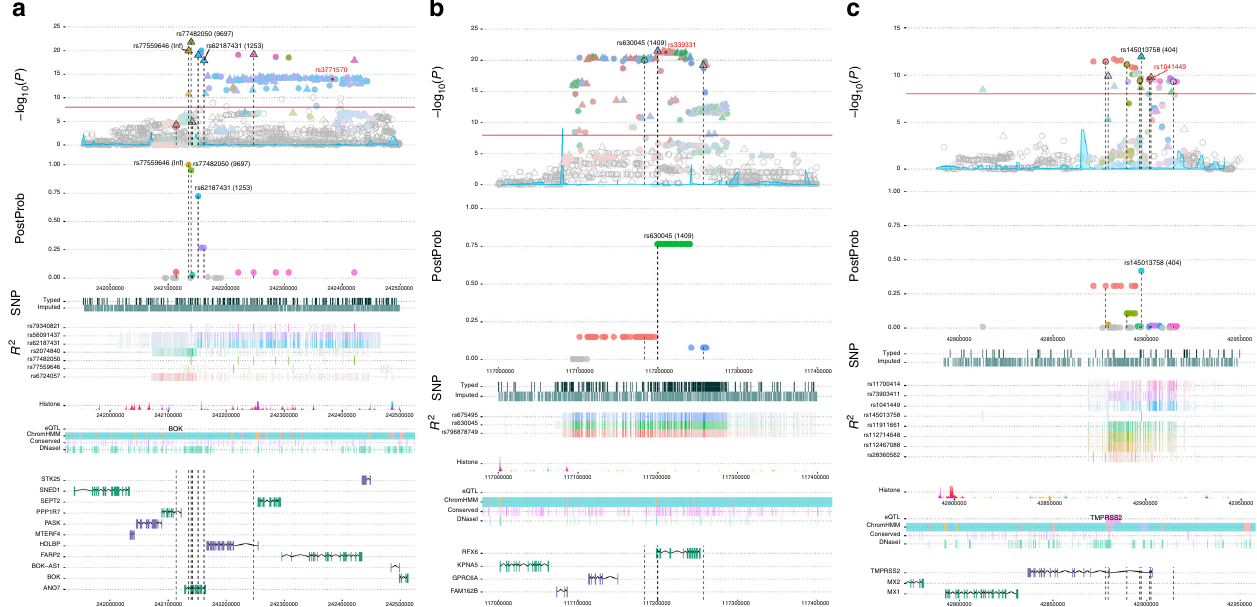
Fig. 3 Locus Explorer plots of results and annotations at three regions. a Chr2q37- ANO7 ; b Chr6q22- RFX6 ; c Chr21q22- TMPRSS2 . Upper section shows regional association plots for the initial EUR meta-analysis data depicting variant P -values ( − log 10 ( P ) panel) and fi ne-mapping results indicating the posterior probability of association for priority pruner tags (PostProb panel). Triangles and circles on the meta-analysis plot denote variants directly genotyped in the OncoArray study and imputed variants respectively, with colours used to indicate all variants in linkage disequilibrium (LD) at r 2 > 0.5 with those selected in the credible set. Names of the representative variants for each independent signal used in the familial relative risk calculation are shown in black and the original GWAS tag SNP marked in red. Only variants selected in the credible set are shown on the fi ne-mapping results plot, with positions of tags included in the 95% credible set marked as dashed lines and positions of all their respective proxy SNPs indicated as coloured circles. Middle section shows additional information regarding the density of directly genotyped variants within the OncoArray cohort and total imputed markers analysed (SNP panel) and the extent of variation correlated with tags in the credible set at LD r 2 > 0.5 ( R 2 panel). Lower section indicates the relative positions of genes and biological annotations. Genes on the positive and negative strand are denoted by green and purple colours, respectively. Annotations displayed are as follows: histone modi fi cations in ENCODE tier 1 cell lines (Histone track); the positions of variants that are eQTLs with prostate tumour expression in TCGA prostate adenocarcinoma samples and the respective genes for which expression is altered (eQTL track); chromatin state categorisations in the PrEC cell line by ChromHMM (ChromHMM track); the position of conserved element peaks (Conserved track); and the position of DNaseI hypersensitivity site peaks in ENCODE prostate cell lines (DNaseI